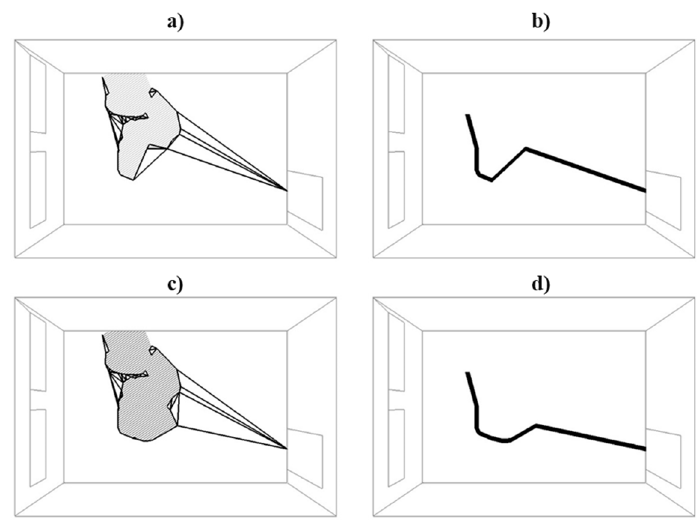
Figure 5. Pathfinding procedure: ( a , c ) navigable networks (solid lines) with obstacle areas (dashed polygons); ( b , d ) paths (thick solid lines) calculated in consecutive iterations.